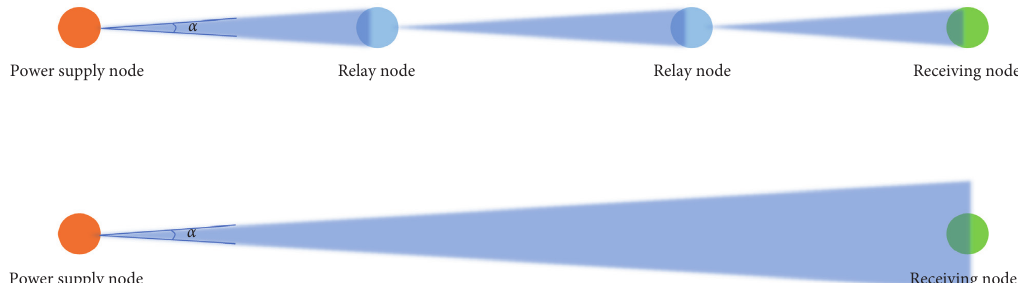
Figure 1: Comparison diagram of geometric